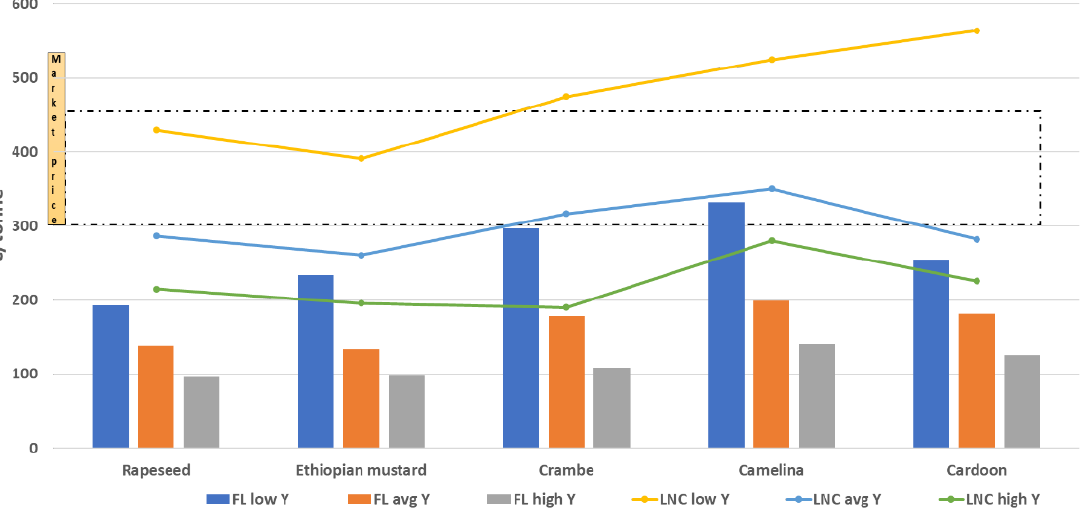
Figure 4. Oil crops production cost ranges in € /tonne seed (with yield increases) in farming land (FL) and in land with natural constraints (LNC). Details in Table 4. Table 4. Profitability of the understudy crops in conventional land and in land with natural constraints (in red the non-profitable